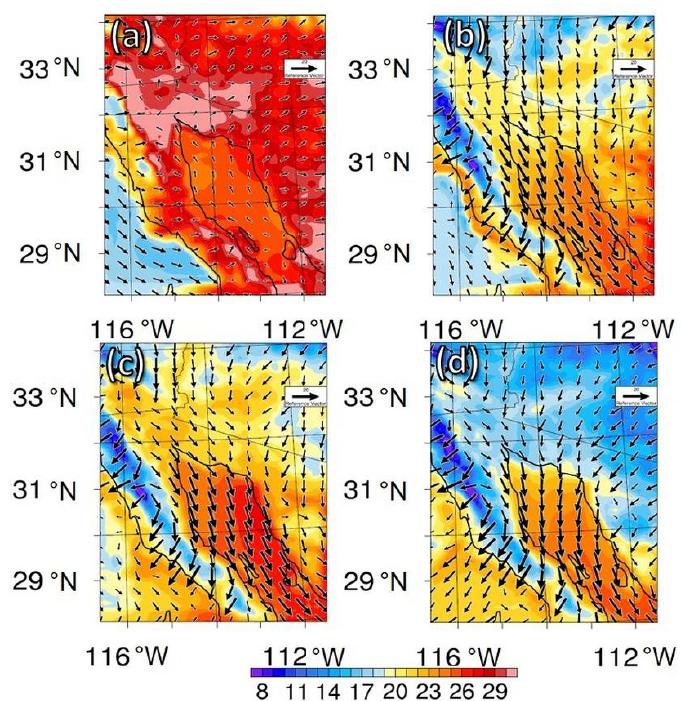
Figure 4 . Temperature (°C) and wind vectors with a magnitude reference of 20 m/s at surface level in Figure 4. Temperature ( ◦ C) and wind vectors with a magnitude reference of 20 m / s at surface level in domain 1. (a) 00:00 UTC on October 21, (b) 17:00 UTC on October 21, (c) 02:00 UTC on October 22 and domain 1. ( a ) 00:00 UTC on October 21, ( b ) 17:00 UTC on October 21, ( c ) 02:00 UTC on October 22 and (d) 10:00 UTC on October 22. ( d ) 10:00 UTC on October